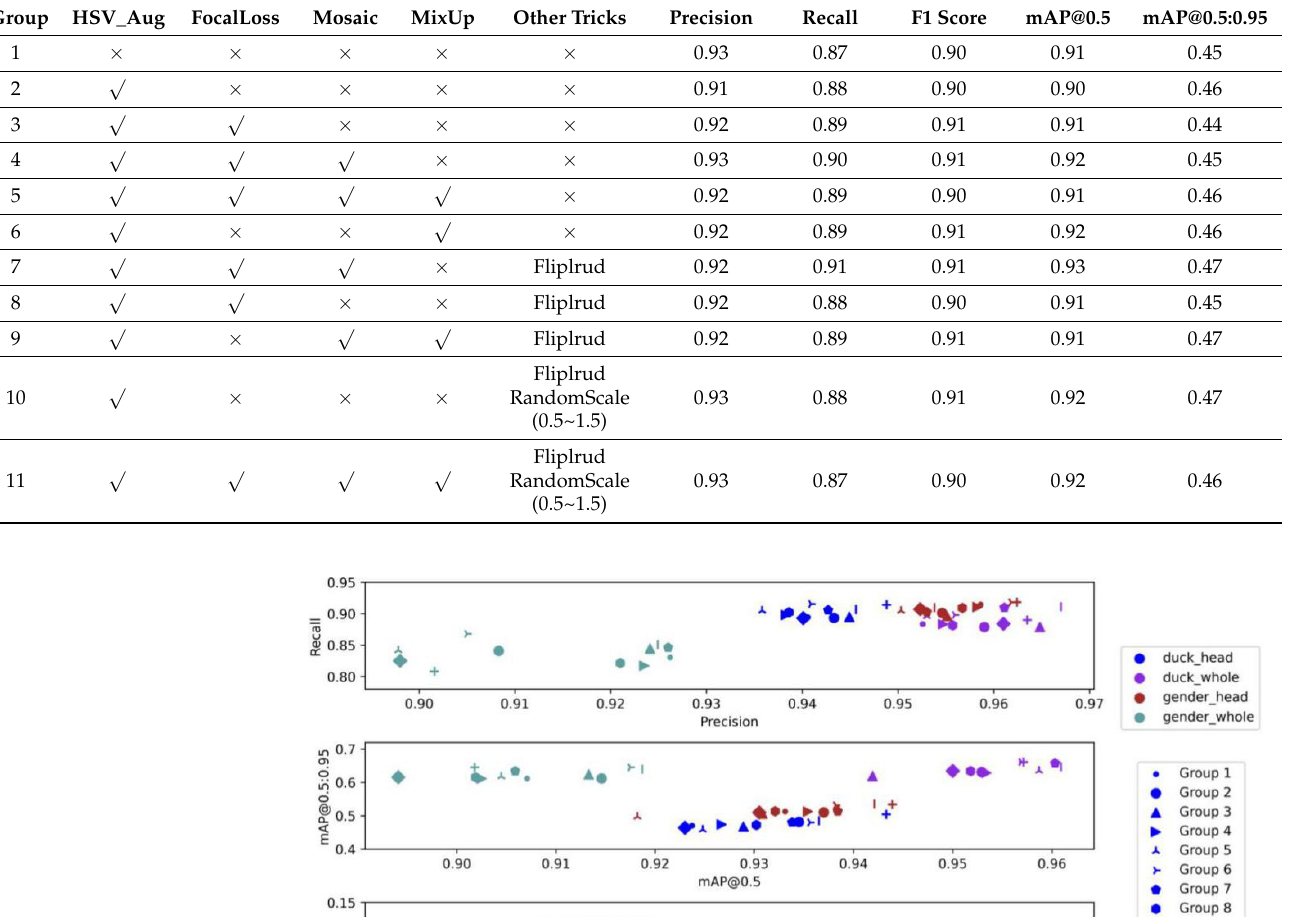
Table 3. In ablation experiment of Yolov5, each group of experiments corresponds to a group of tricks and evaluation metrics. The “ × ” means that the trick is not used and the “ is used.